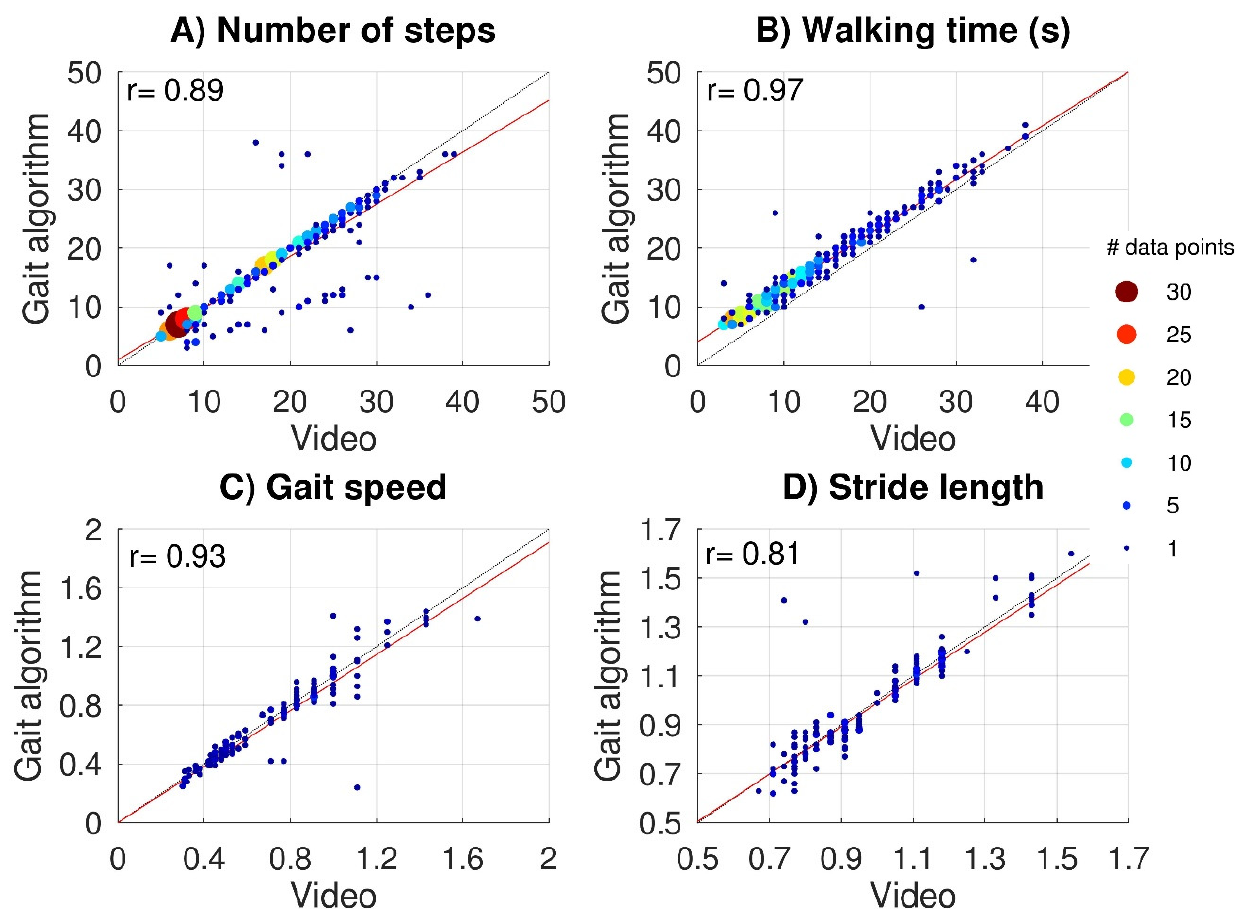
Figure 3. Validation of IMU data. Scatter plots of video-based versus IMU-based gait parameters. The upper panels show the capacity-based number of steps ( A ) and capacity-based walking time ( B ) for 465 subtasks performed by 22 subjects. Lower panels show capacity-based gait speed ( C ) and capacity-based stride length ( D ) for 154 10mWTs. Black dashed lines represent perfect-fit (x = y), whereas the red lines represent the regression lines. Multiple (overlapping) data points are indicated with bigger color-coded data points.